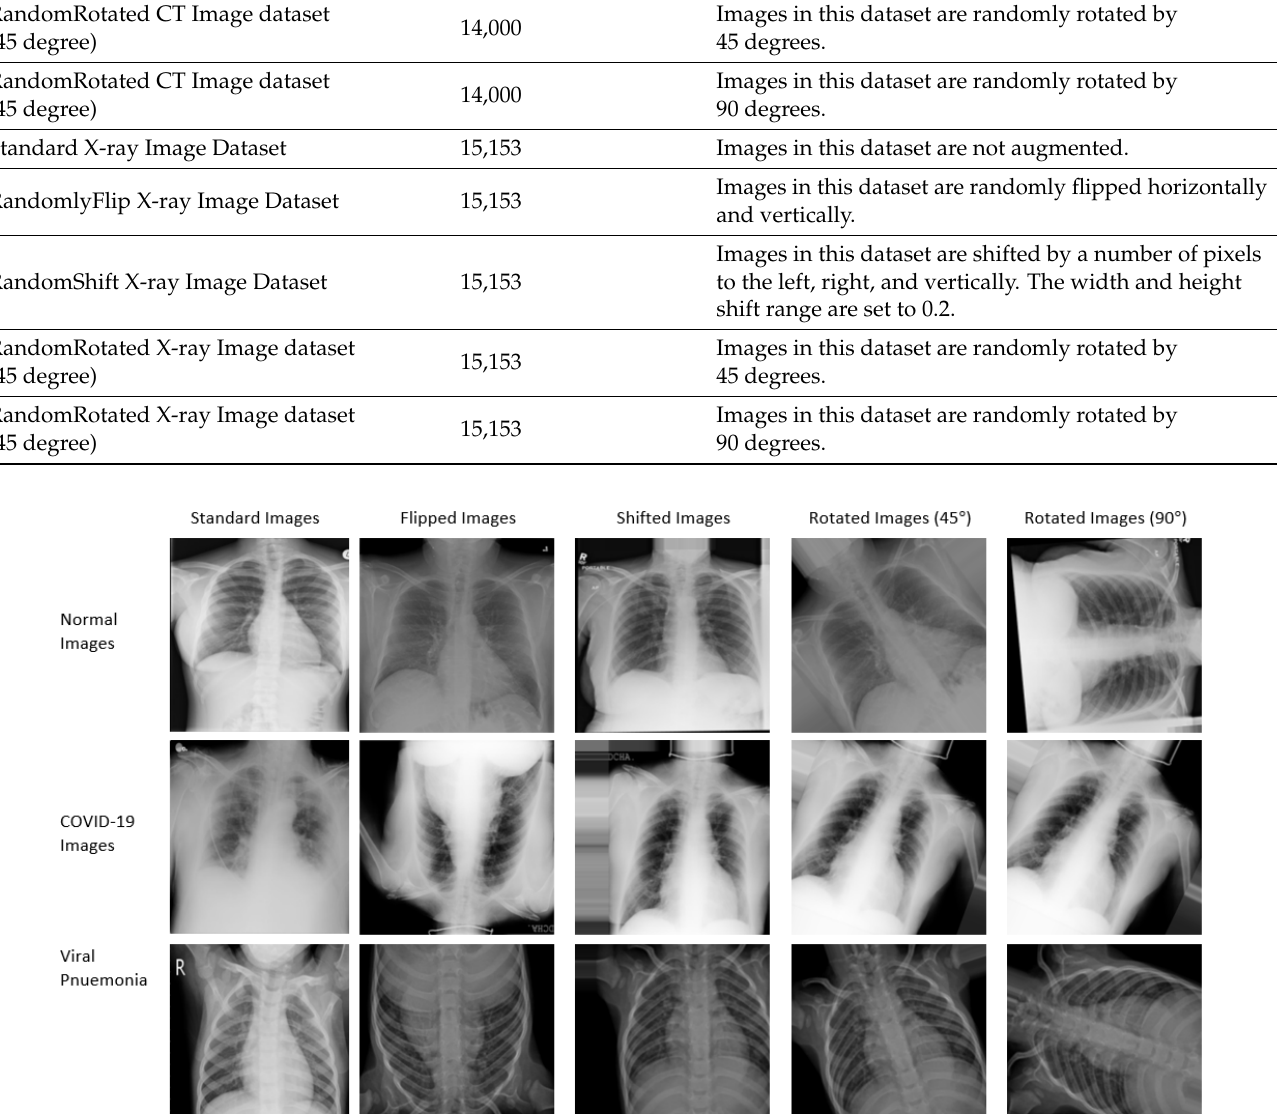
Figure 2. Samples of standard and augmented CT images used for training.